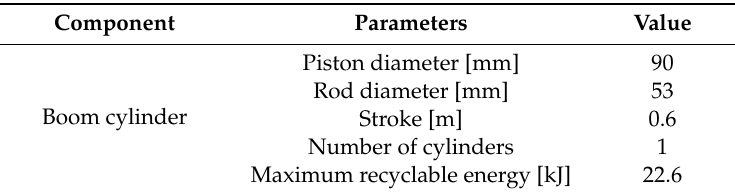
Table 2. Parameters of the boom cylinder of a 4 t